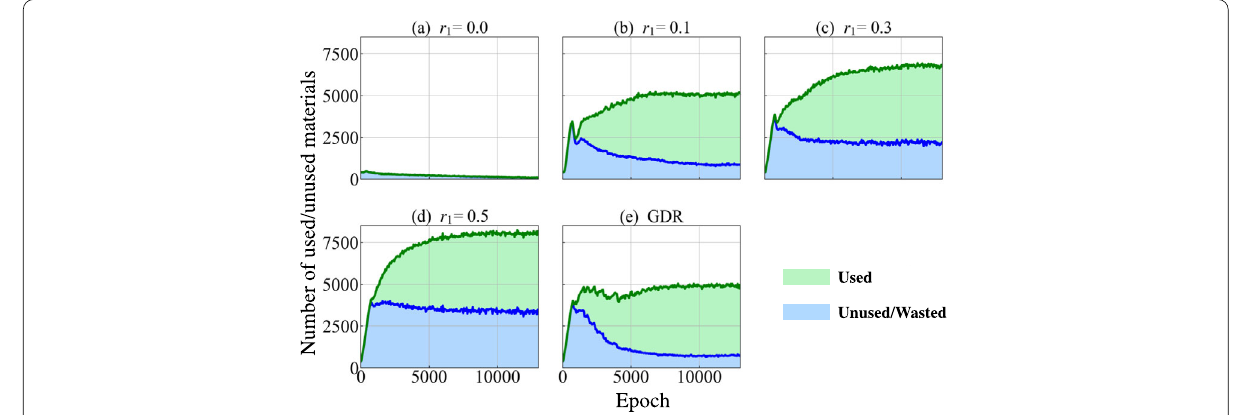
Figure 6 Number of used and unused (so wasted) materials during the course of